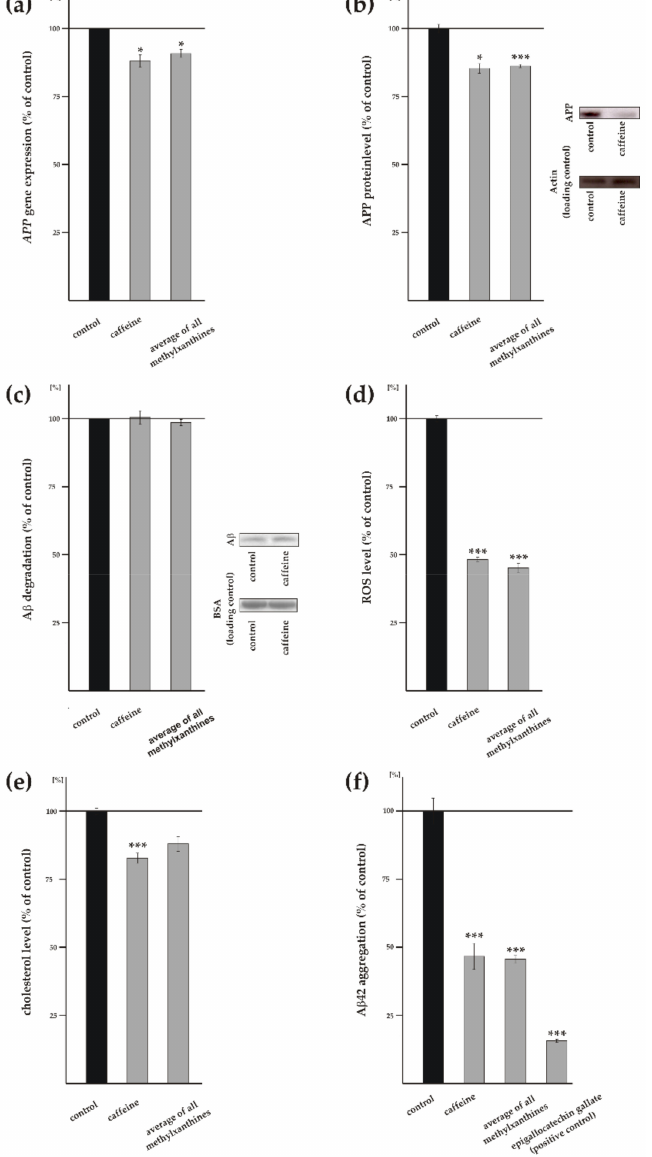
Figure 5. E ff ects of MTXs on APP level, A β catabolism and aggregation, reactive oxygen species and cholesterol. ( a ) Gene expression of APP was analyzed by RT-PCR ( n ≥ 10). ( b ) Protein level of APP ( n ≥ 9). Representative WBs including load control are shown on the right. ( c ) Degradation of A β ( n ≥ 11). Representative WBs including load control are shown on the right. ( d ) Influence of MTXs on reactive oxygen species (ROS) level (hydroxyl radical, hypochlorite, peroxynitrite) ( n ≥ 8). ( e ) Level of cholesterol in treated human neuroblastoma cells ( n ≥ 4). ( f ) E ff ect of ca ff eine and MTXs on aggregation of A β 42 ( n ≥ 20). Epigallocatechin gallate (EGCG) served as positive control. Error bars represent the standard error of the mean. Asterisks show the statistical significance calculated by unpaired Student’s t test (* p ≤ 0.05; ** p ≤ 0.01; *** p ≤